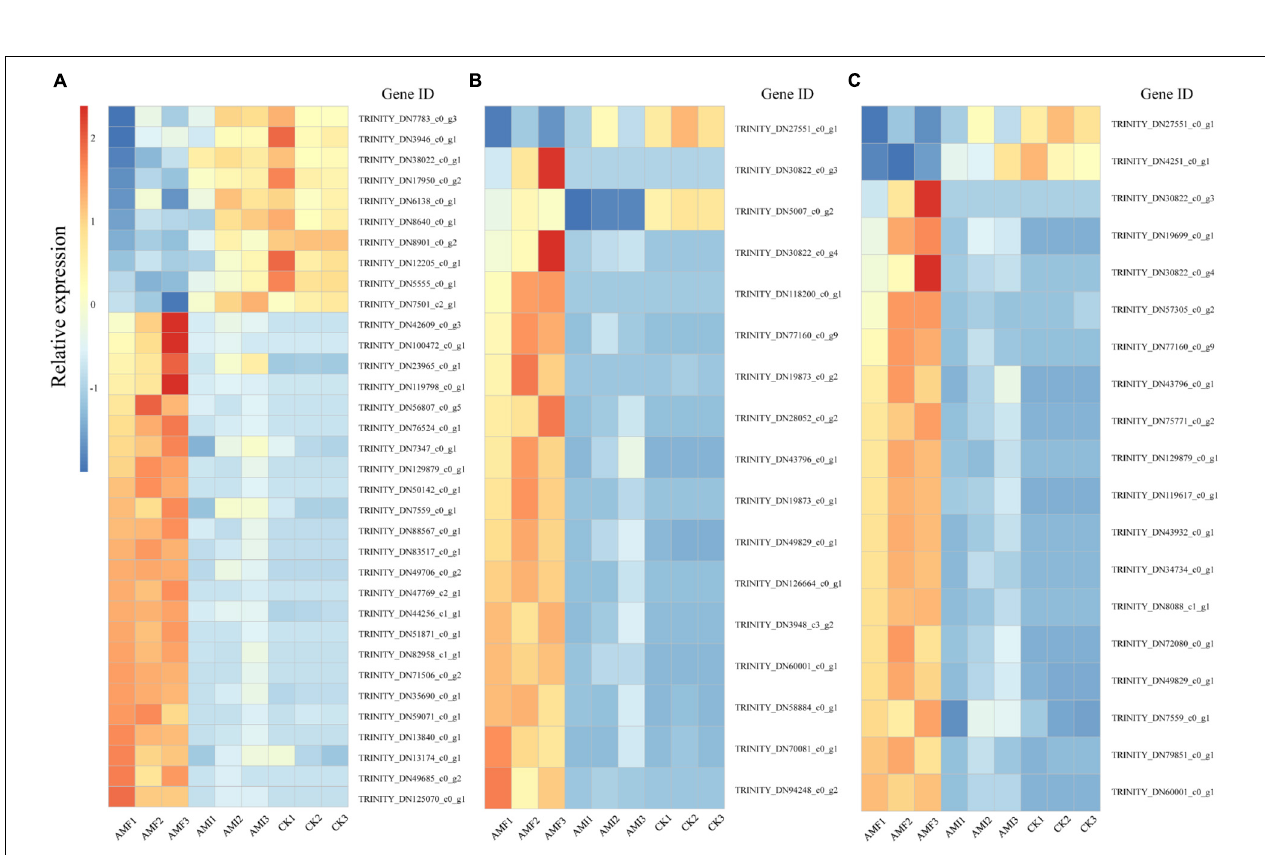
FIGURE 5 | AM-induced genes regulated by indigenous microorganisms related to different categories. (A) AM-induced genes regulated by indigenous microorganisms related to P metabolism. (B) AM-induced genes regulated by indigenous microorganisms related to N metabolism. (C) AM-induced genes regulated by indigenous microorganisms related to amino acid metabolism. The horizontal axis represents the sample and the vertical axis represents the gene ID. The AMF , AMI , and CK mean the same as in Figure 1 . Description and expression of genes related to different categories in AMF and AMI are listed in Supplementary Tables 3–5 ,